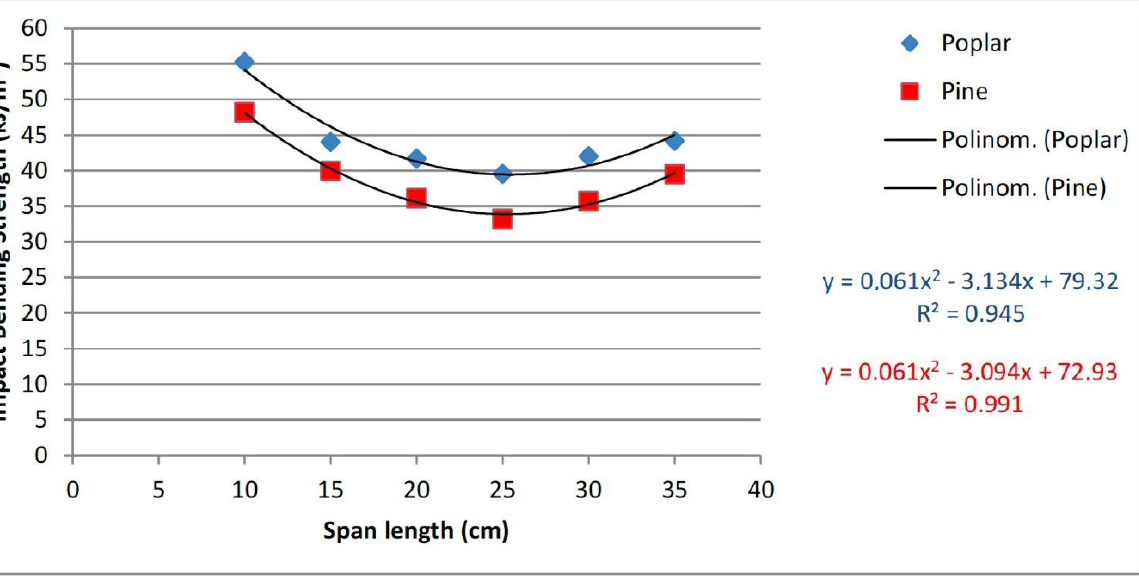
Figure 47. Plots of the impact bending strengths of Poplar and Pine specimens as a function of the span length of the original specimens. From [166].